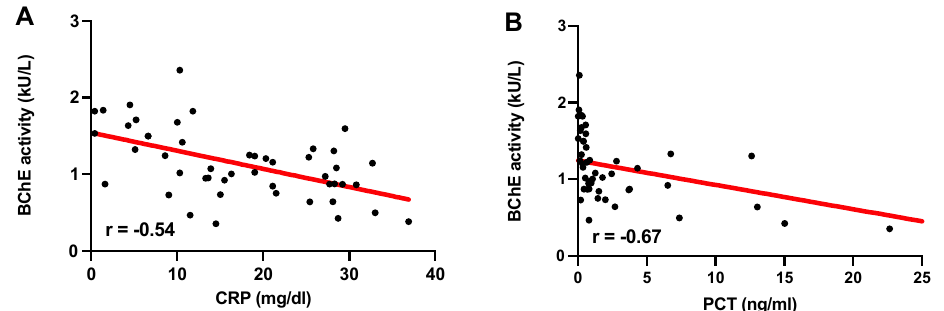
Figure 5. Correlation analysis of BChE activity with CRP and PCT levels in critically ill COVID-19 patients. Correlation of BChE activity with CRP (r = − 0.54); ( A ) and with PCT (r = − 0.67); ( B ) on day 7; p < 0.05, Spearman’s rank correlation test.